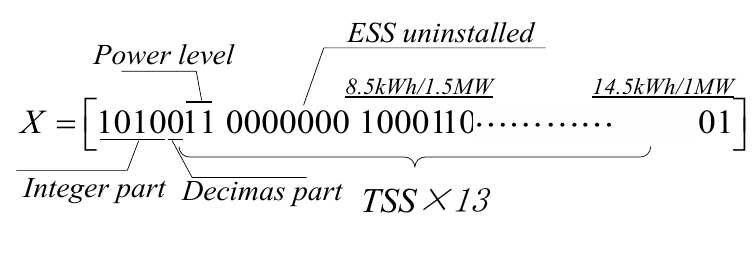
Figure 18. The encoding structure of ESSs location and